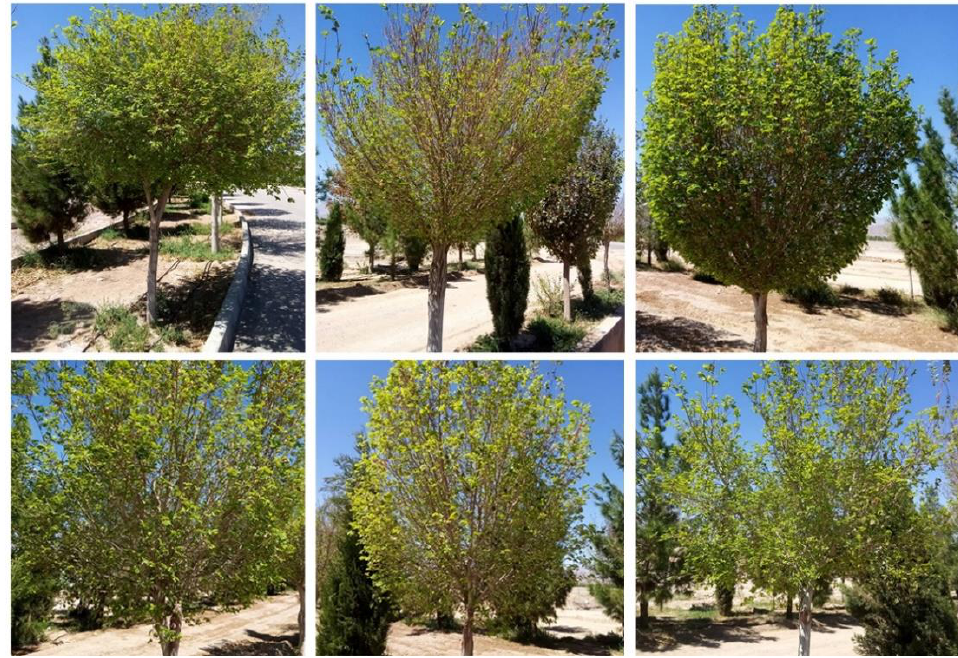
Figure 1. A photo of parts of the green space of Karizland [31].